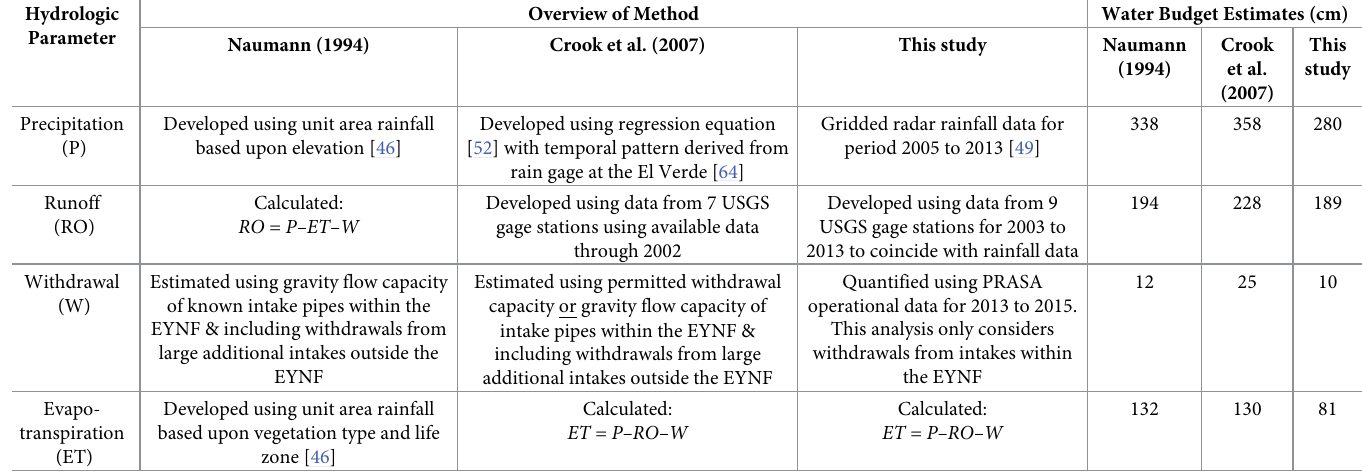
Table 3. Comparison of our current hydrologic budget for EYNF with two prior water budgets. It is important to note the difference in geographic scope of the three budgets with respect to accounting for water withdrawals. Our current study accounts for all water withdrawals within the EYNF. In contrast, the previous two studies con- sidered large water withdrawals outside of the